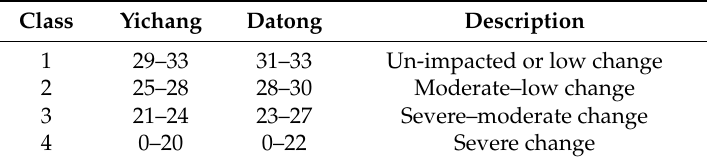
Table 7. Assessment criteria of number of factors in a typical year at Yichang and Datong